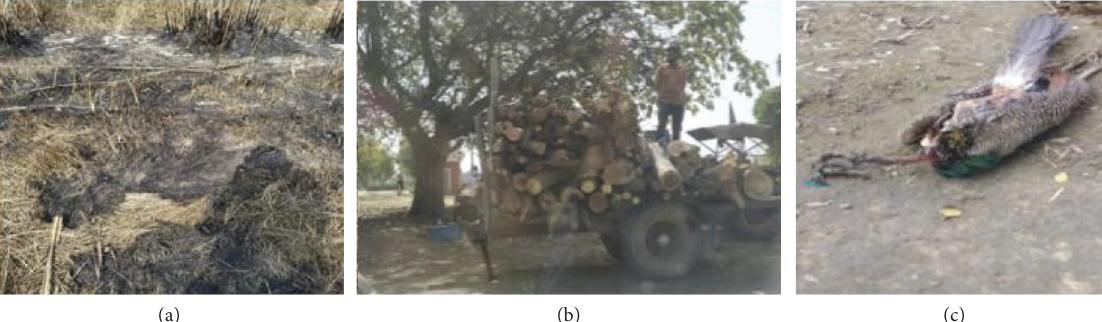
Figure 5: Human interference in Parikshitgarh. (a) Ashes observed due to fre in bushes, (b) illegal deforestation and wood log loading in trolley, (c) electrocution of the peacock.